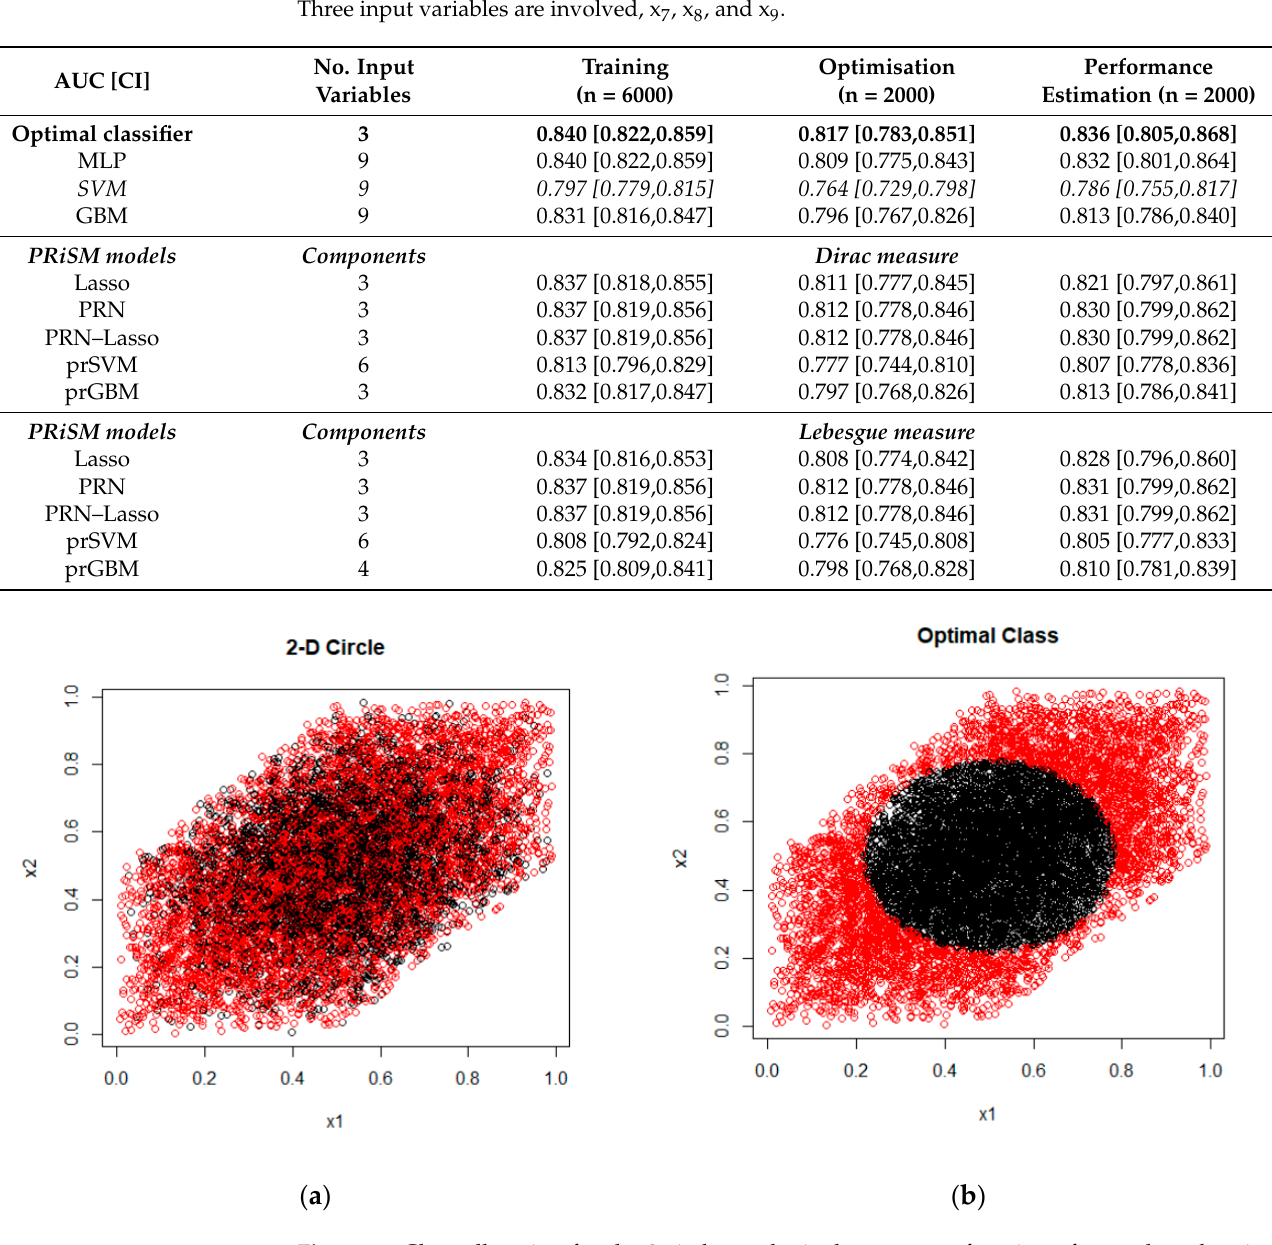
Figure 3. Class allocation for the 2-circle synthetic data set as a function of x 1 and x 2 showing: ( a ) The stochastic class labels; and ( b ) The correct classes that are used to find the optimal AUC.